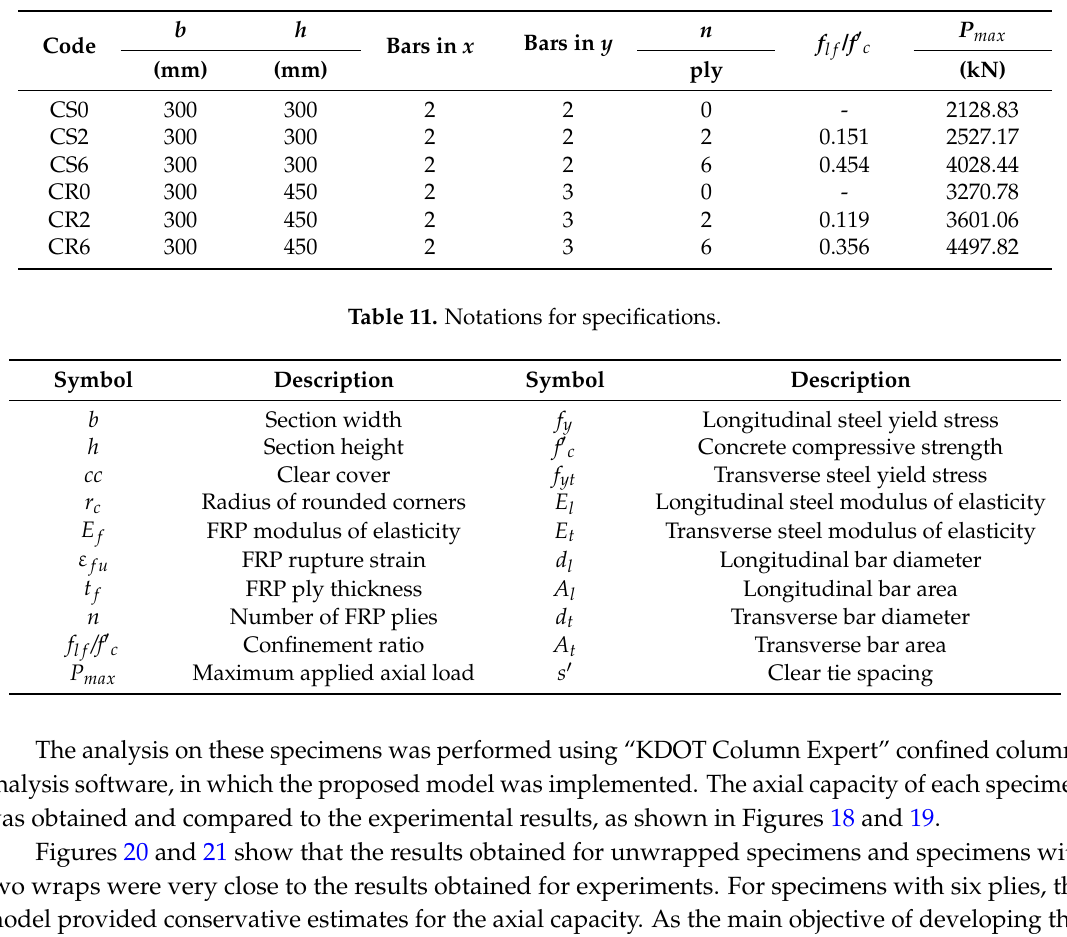
Table 10. Section properties for set 2 specimens.